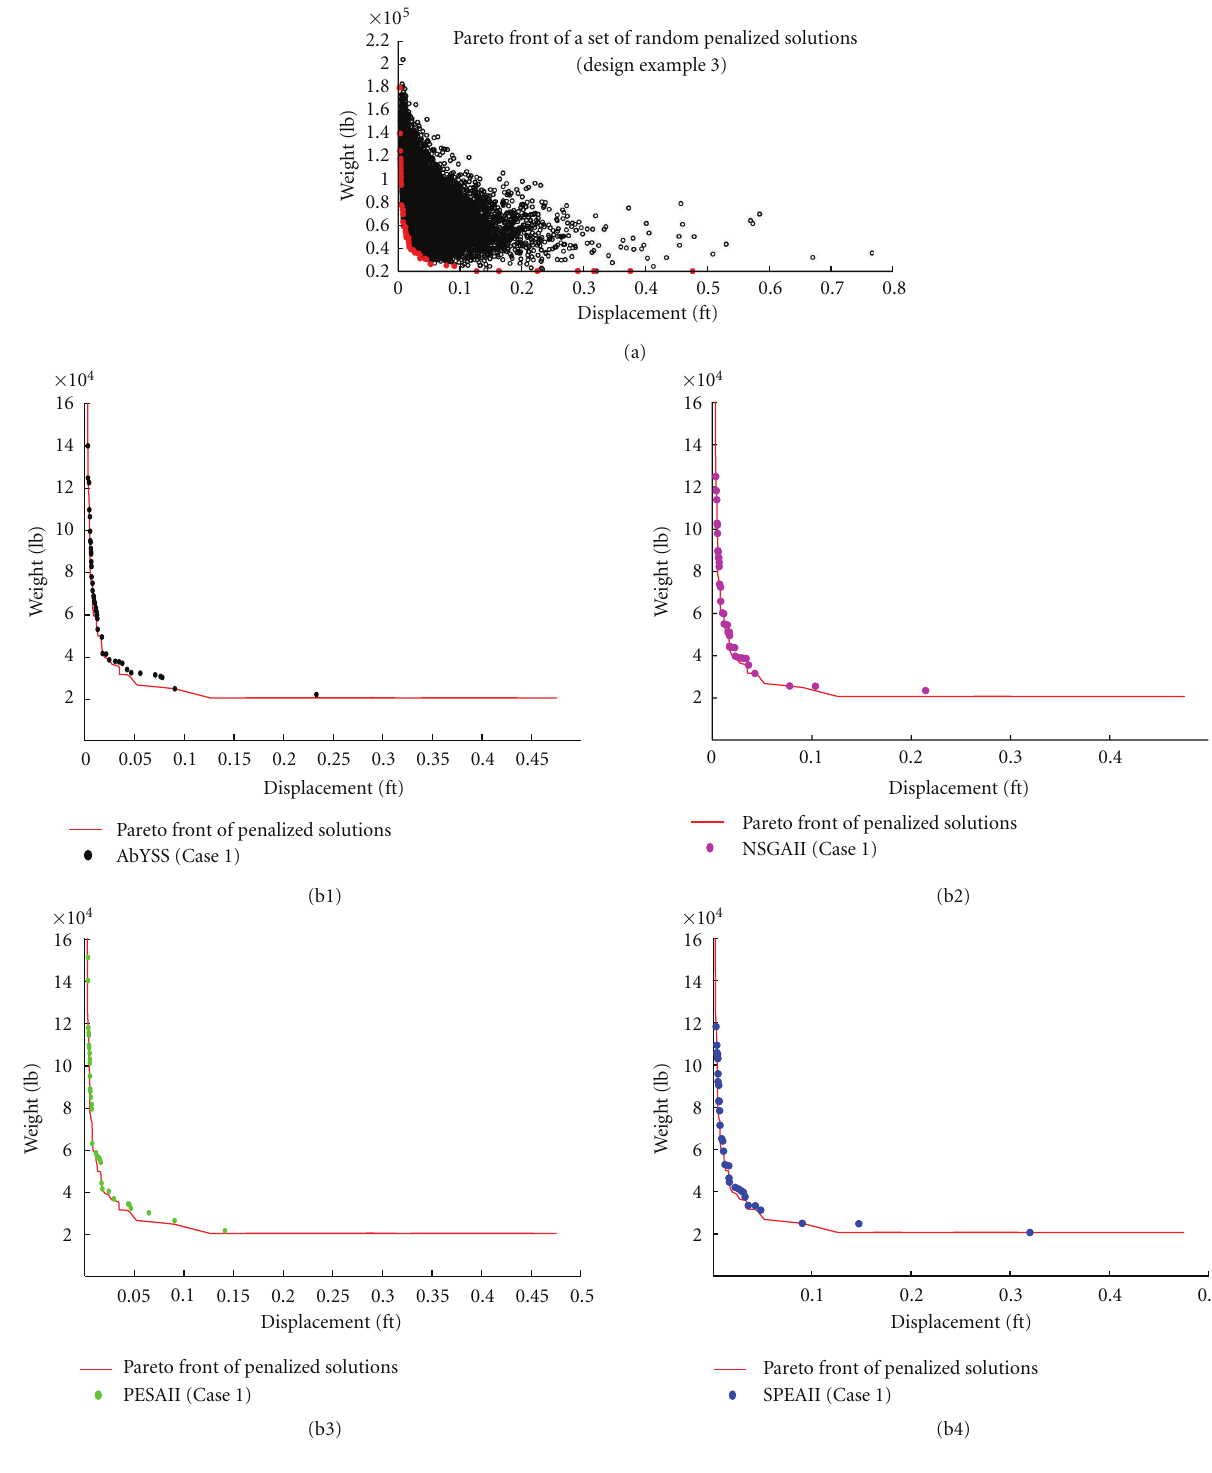
Figure 12: Pareto fronts of a set of random nondominated solutions obtained by use of an increased population size and evolution number (a) and AbYSS, NSGAII, PESAII, and SPEAII